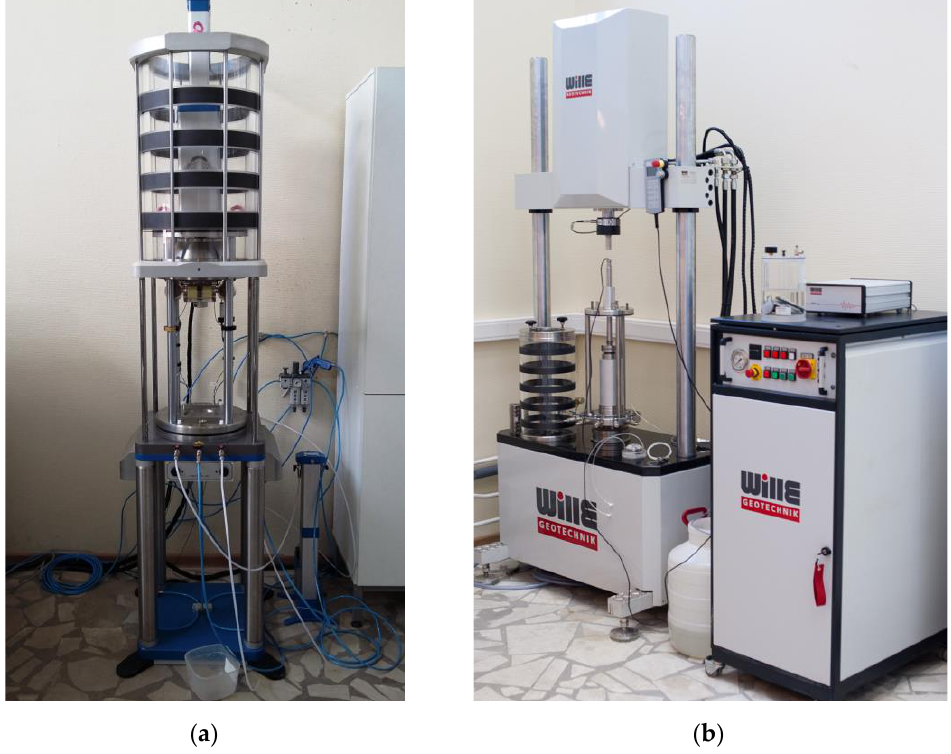
Figure 2. Laboratory equipment for testing dynamic properties of cement stabilized soil. ( a ) Resonant column and ( b ) the apparatus of dynamic triaxial compression.